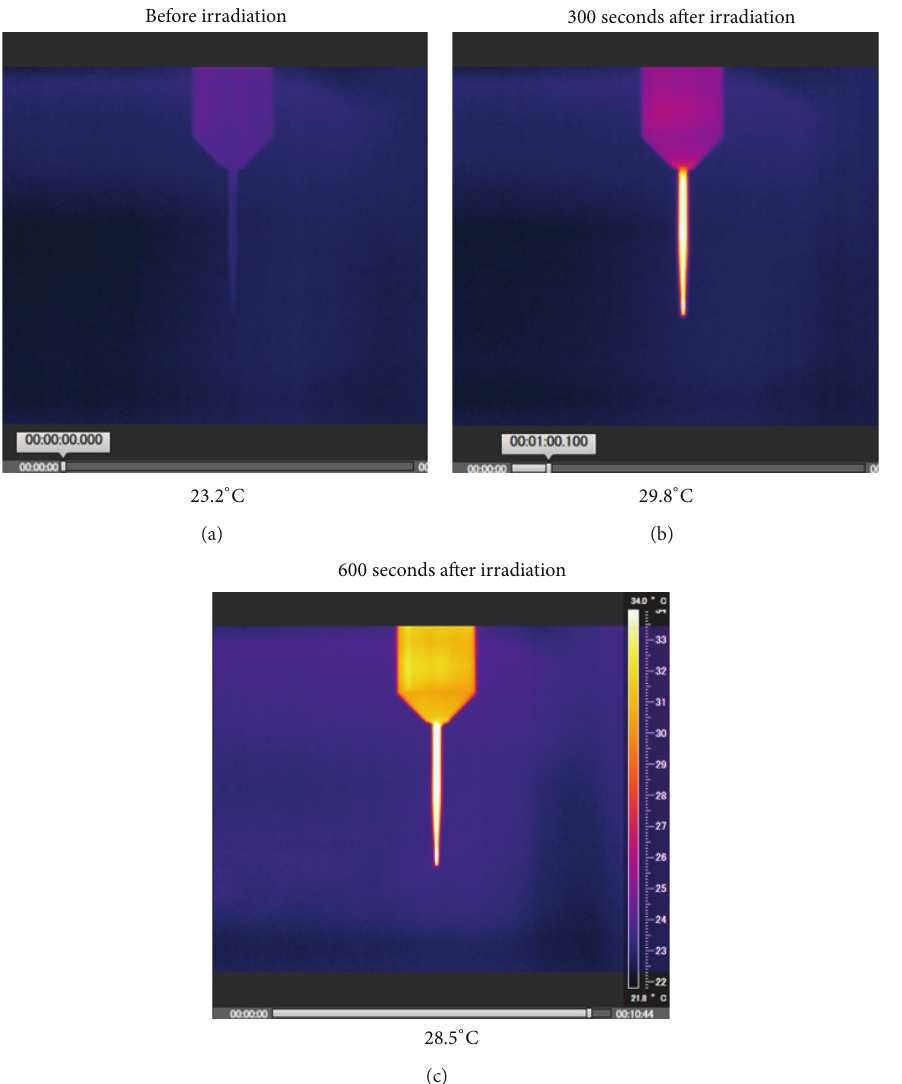
Figure 2: Change in temperature of acrylic irradiation tips. (a) Before laser irradiation; (b) 300 sec after laser irradiation; and (c) 600 sec after laser